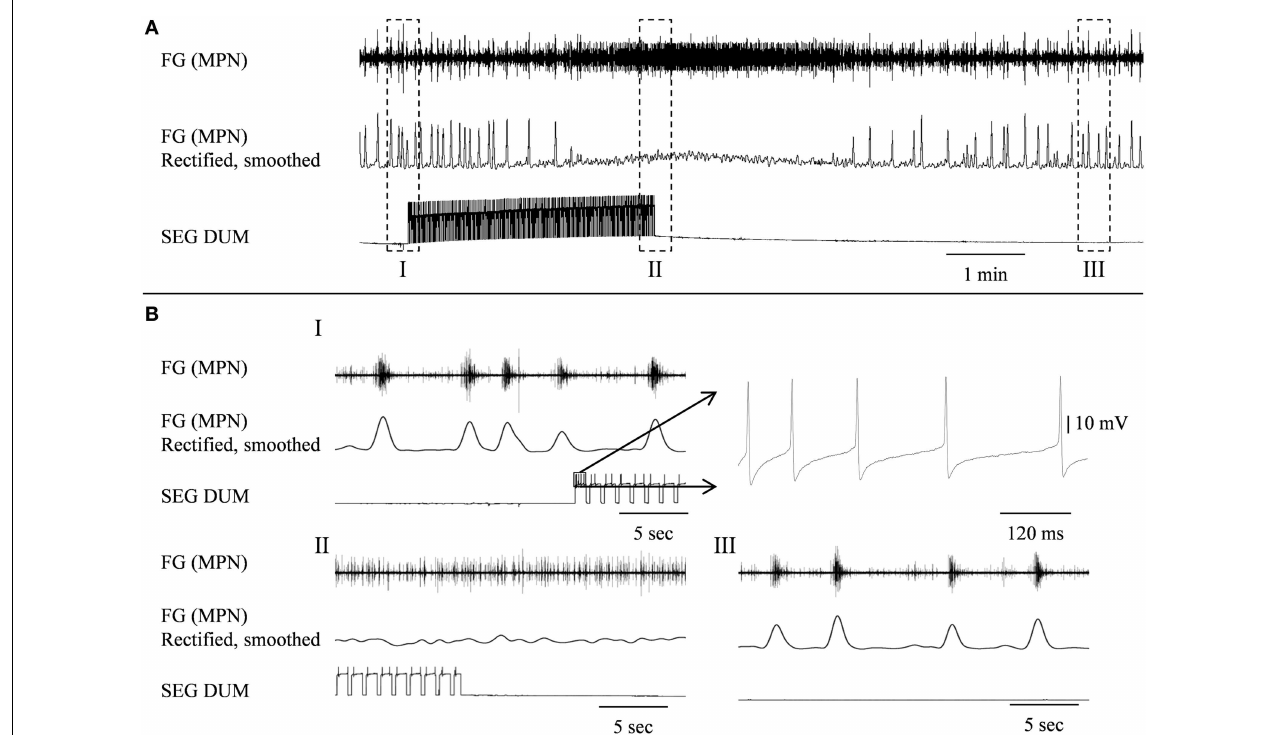
the MPN is shown in the middle trace. (B) Extended time scale of the outlined frames in (A) . (BI) Rhythmic activity of the FG and the beginning of current injection.The outlined action potentials of the DUM neuron are shown to the right on an extended time scale. (BII) Tonic firing of the FG and the end of current injection. (BIII) Restoration of rhythmic activity of the